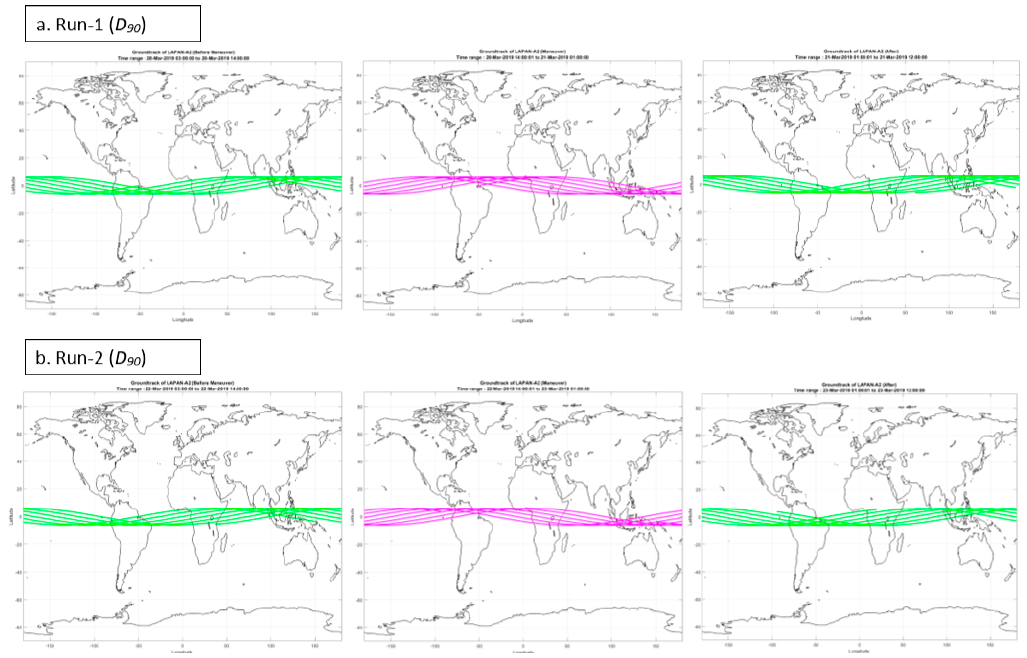
Figure 11. The LAPAN-A2 satellite ground track produced during the 90°-maneuvered observation period.